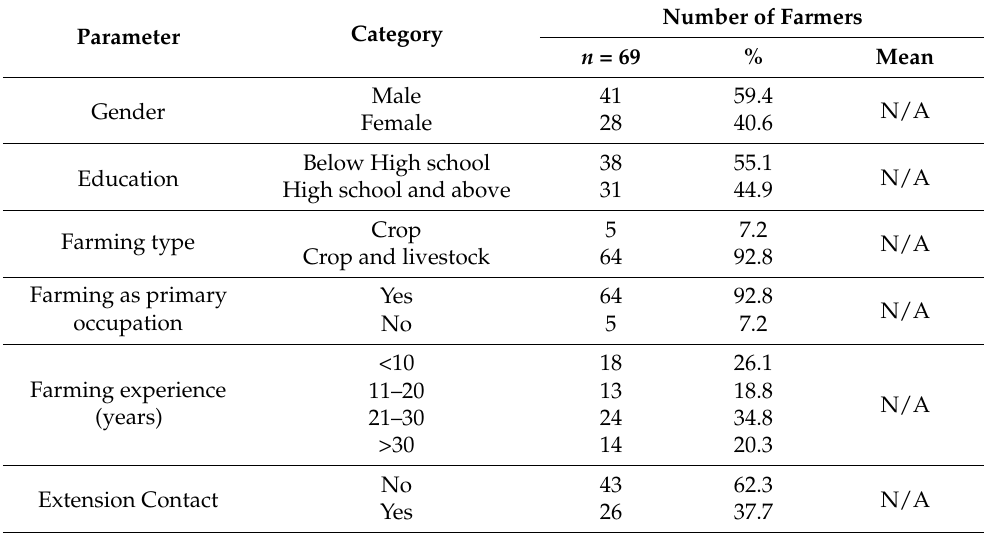
Table 3. Farm household demographic and socio-economic characteristics in upper Eastern